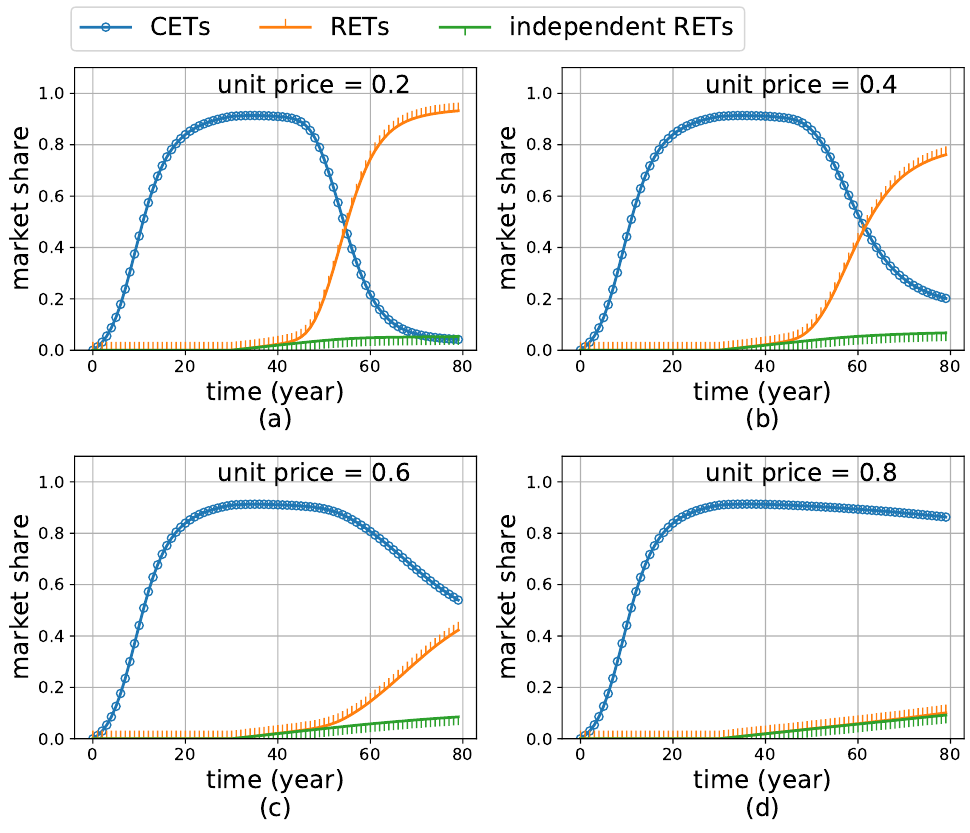
Figure 8. The impact of RETs’ price